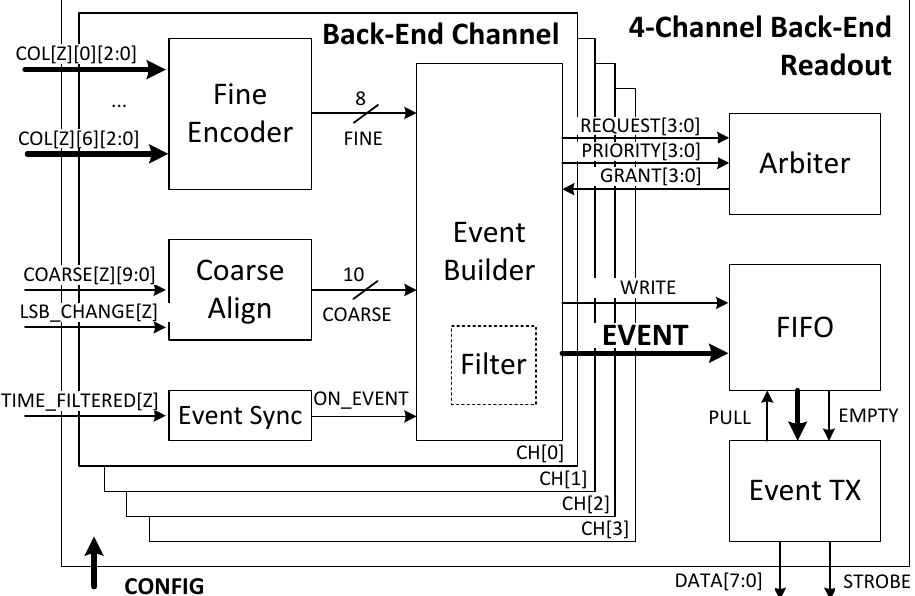
Figure 7. Backend Readout block diagram corresponding to 1 cluster (4